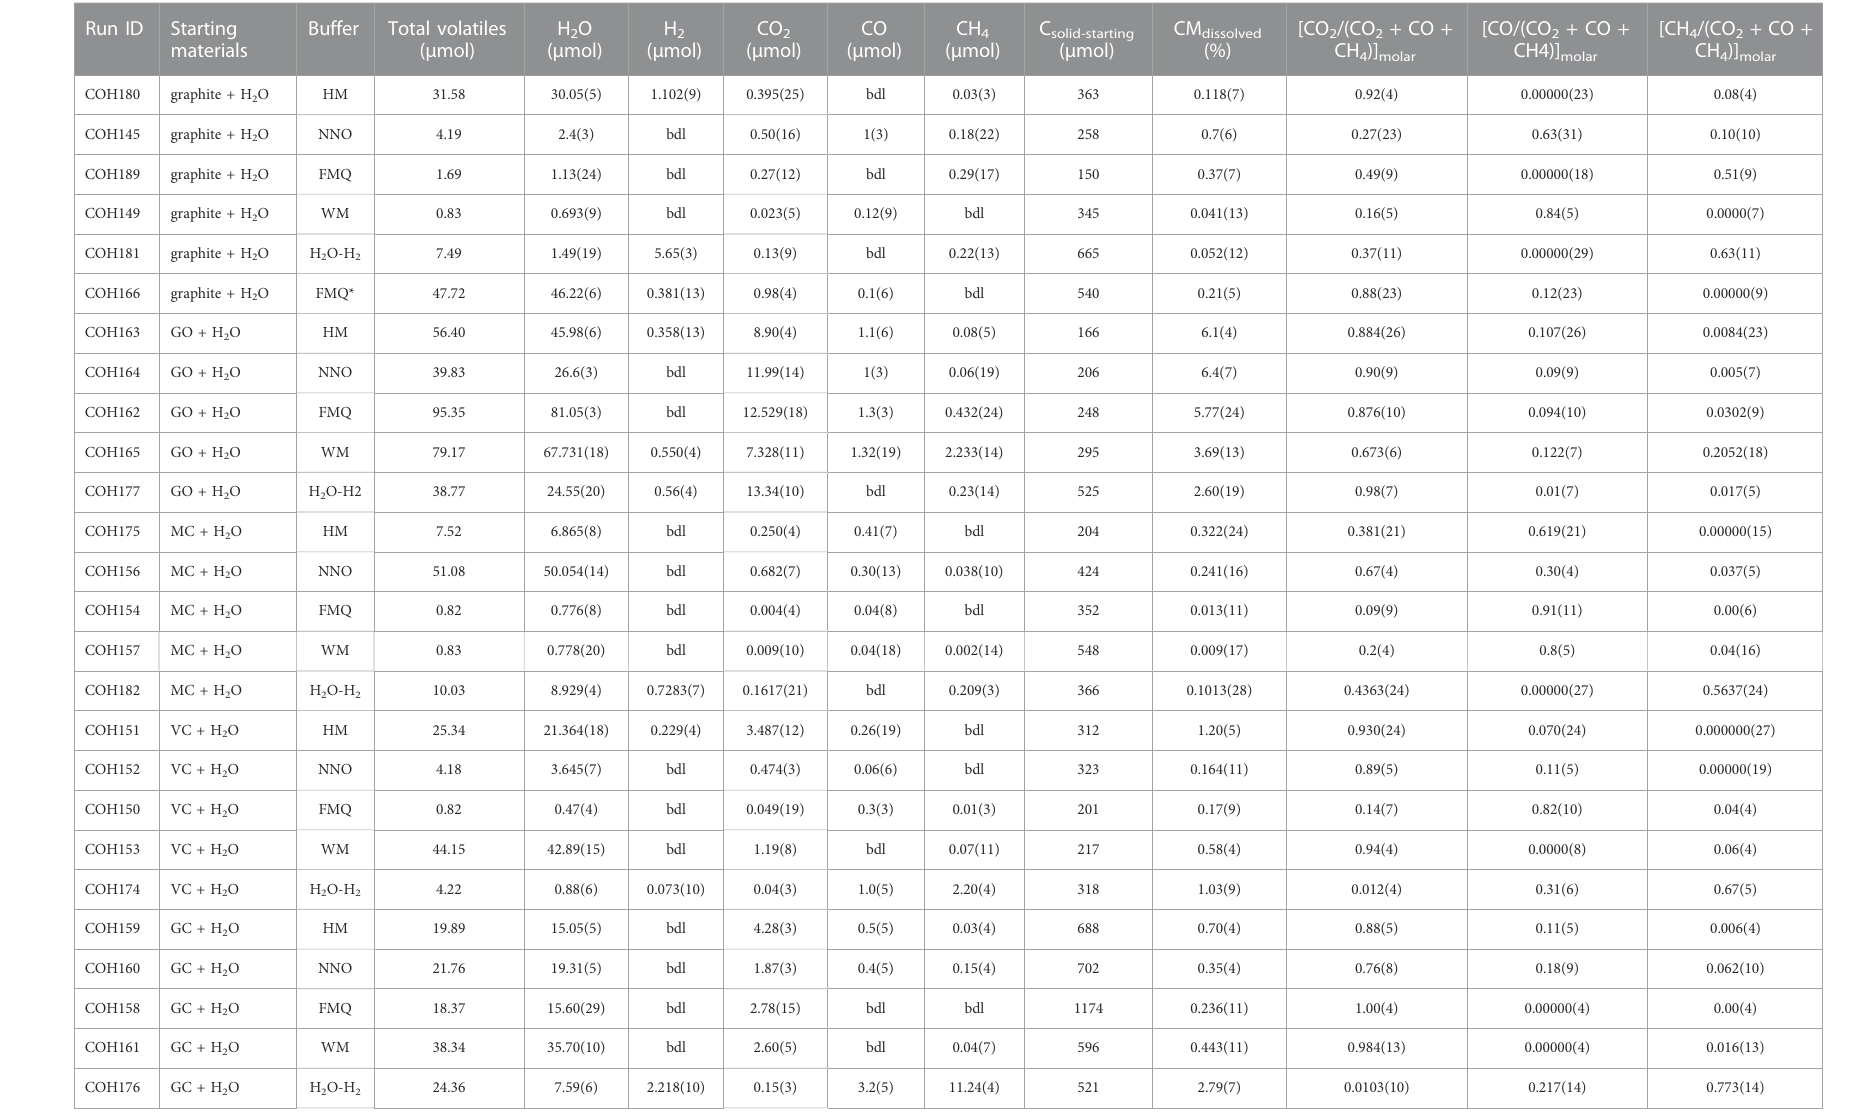
TABLE 3 COH fl uid composition obtained from QMS analyses and data used to produce Figure 3 and Figure 4. Run ID Starting